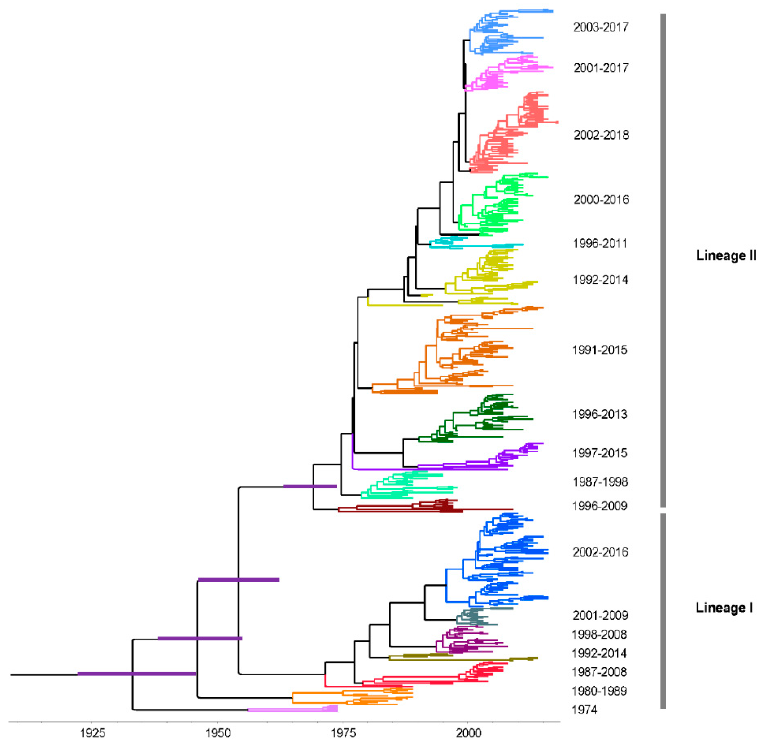
Figure 6. Time-scaled phylogenetic tree of RVA G1 VP7 gene by using the Bayesian Markov Chain Monte Carlo method. Branches are scaled in time and strains are colored according to sub-lineages. Node bars indicate 95% highest posterior densities of the most recent common ancestor.